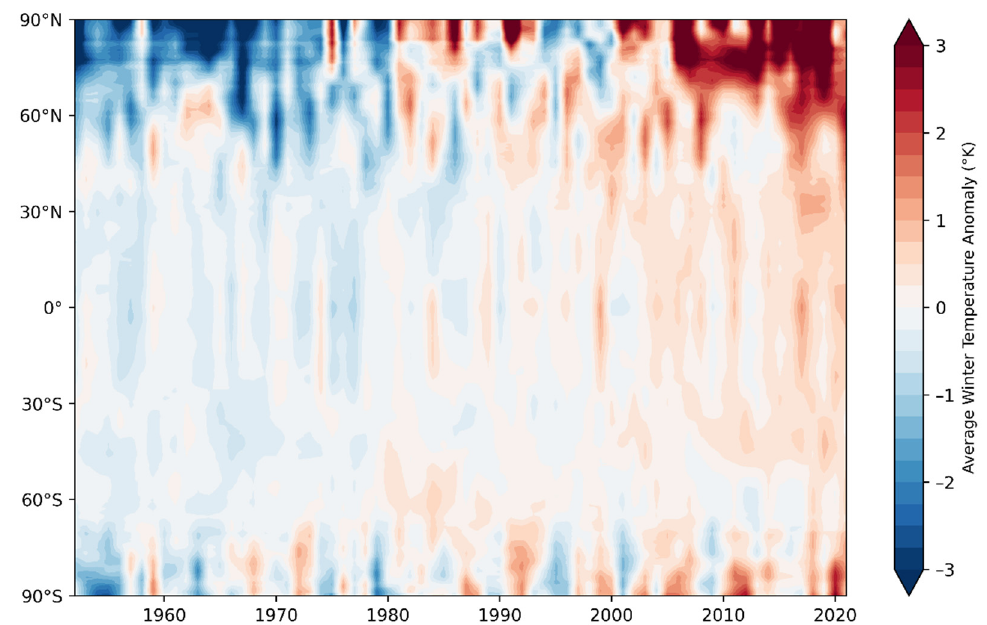
Figure 5. Evolution over time ( x -axis) of zonal mean temperature anomalies ( ◦ C) as a function of latitude ( y -axis). Temperature anomalies are departures from the mean for the 1950–2020 period. Data source: ERA5 reanalysis.